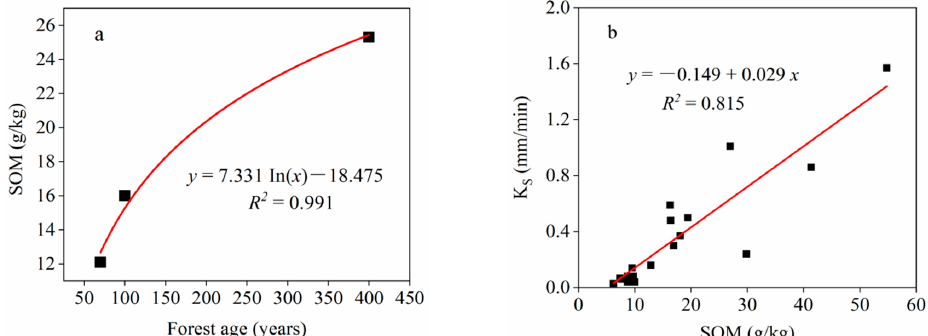
Figure 8. The variation trend of average SOM content across the 0–90 depth with vegetation restoration time ( a ) and the relationship between the SOM and K S ( b ). Abbreviations: SOM, soil organic matter; K S , saturated hydraulic conductivity.